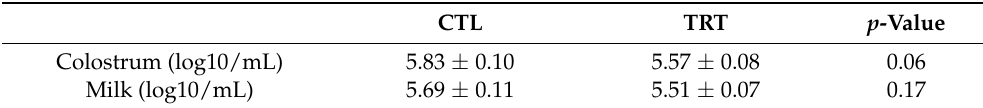
Table 1. Effects of dietary silymarin supplementation during late gestation and lactation on the somatic cell count in sow milk. CTL TRT p -Value Colostrum (log10/mL)